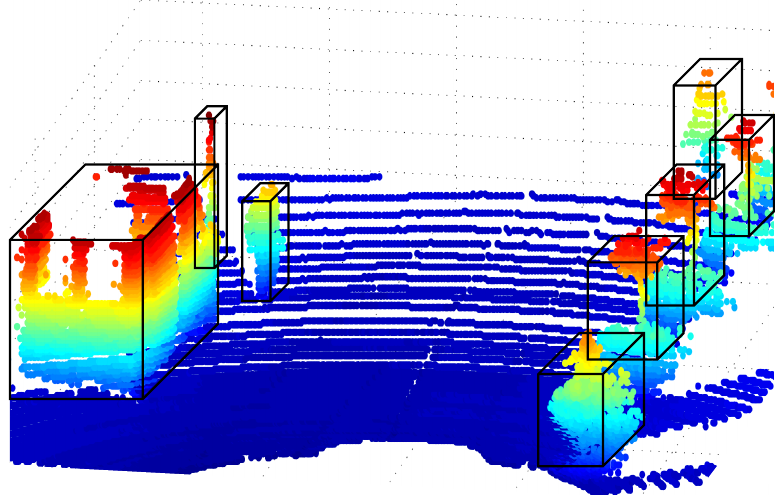
Figure 3. The ideal detection result from a 3D LIDAR with all moving objects detected, adapted from